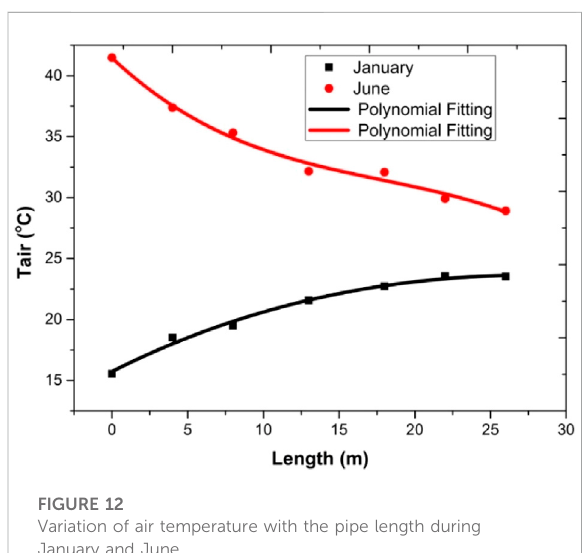
FIGURE 12 Variation of air temperature with the pipe length during January and